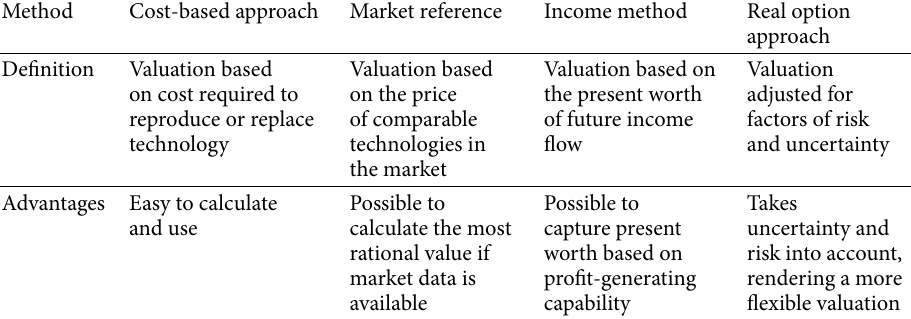
Table 1. Definitions and comparisons of technology valuation